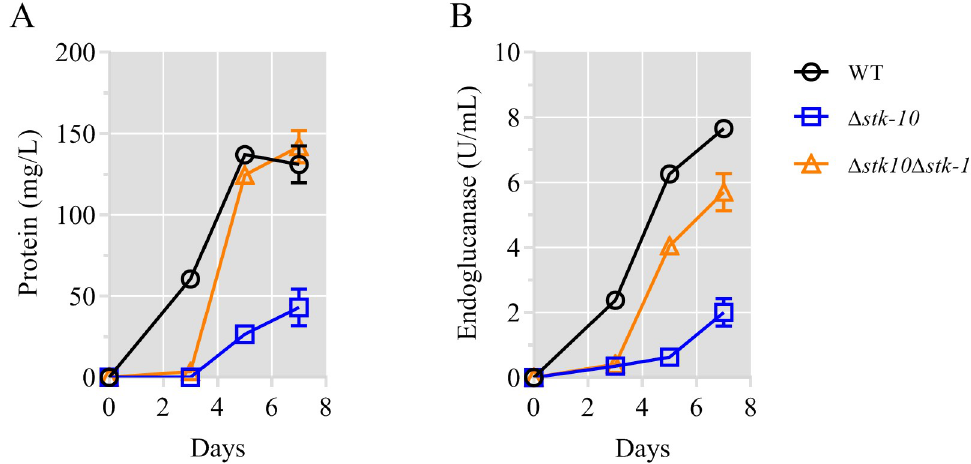
Fig 10. Deletion of stk-12 rescues phenotype of stk-10 mutant on Avicel. Total extracellular protein concentration (A) and endoglucanase activity (B) in culture broth of WT and mutants ( Δ stk-10 and Δ stk-12 Δ stk-10 ) during growth in cellulose medium. Values represent means of at least three biological replicates, error bars show standard